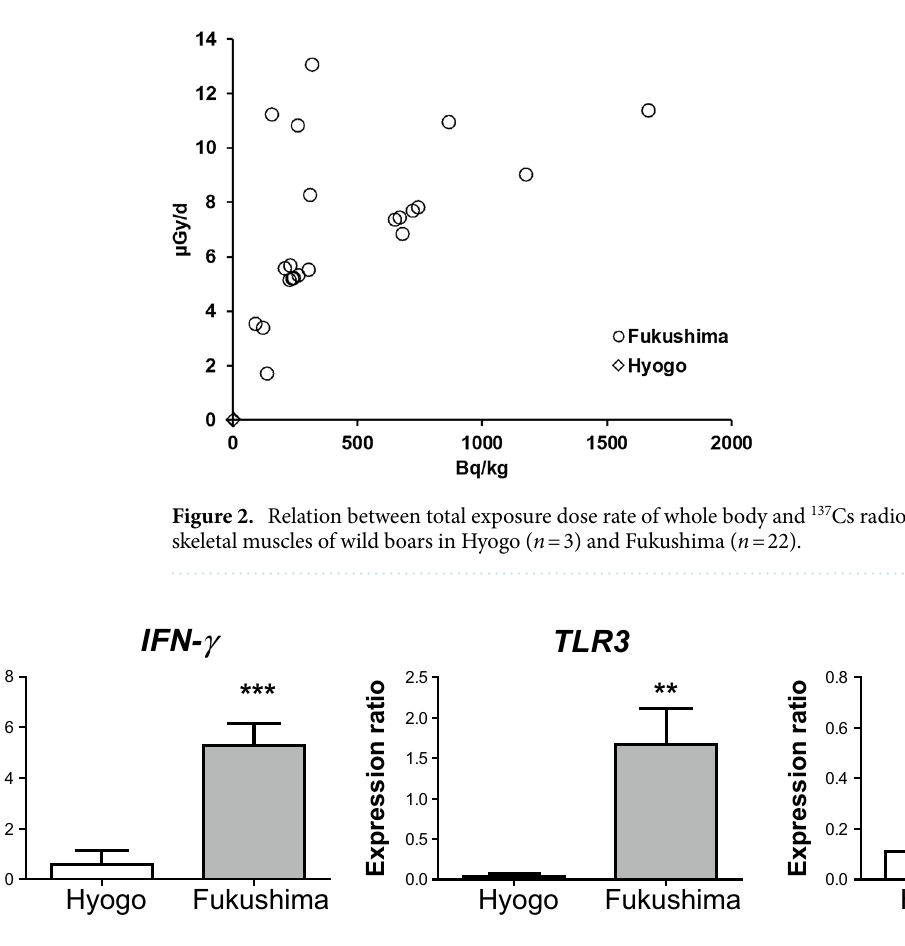
Figure 3. The expression of IFN-γ , TLR3 , and CyclinG1 in the small intestine of wild boars in Hyogo and Fukushima. The expression ratio of these genes in Fukushima wild boars was significantly higher than that in Hyogo wild boars. All data are expressed in relative units. ** P < 0.01, *** P < 0.001, data are presented as mean ±